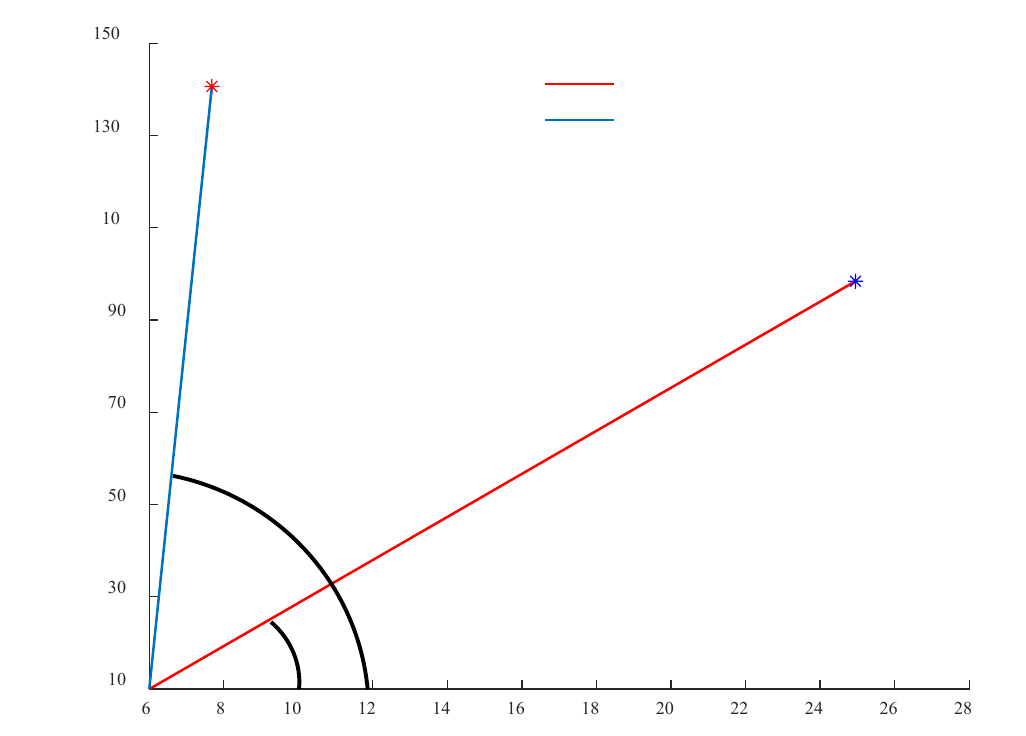
Figure 4. Schematic diagram of